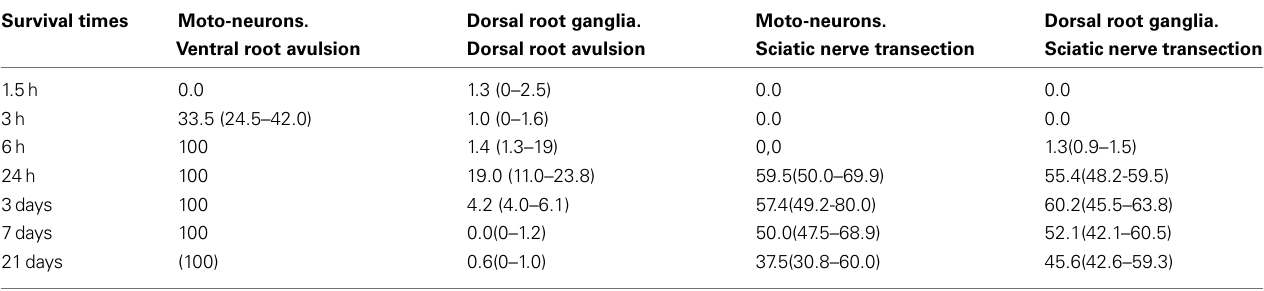
Table 1 | Showing the median (range) of the ratio (%) betweenATF3 labeled and total number of MN and dorsal rot ganglia neurons after different types of nerve